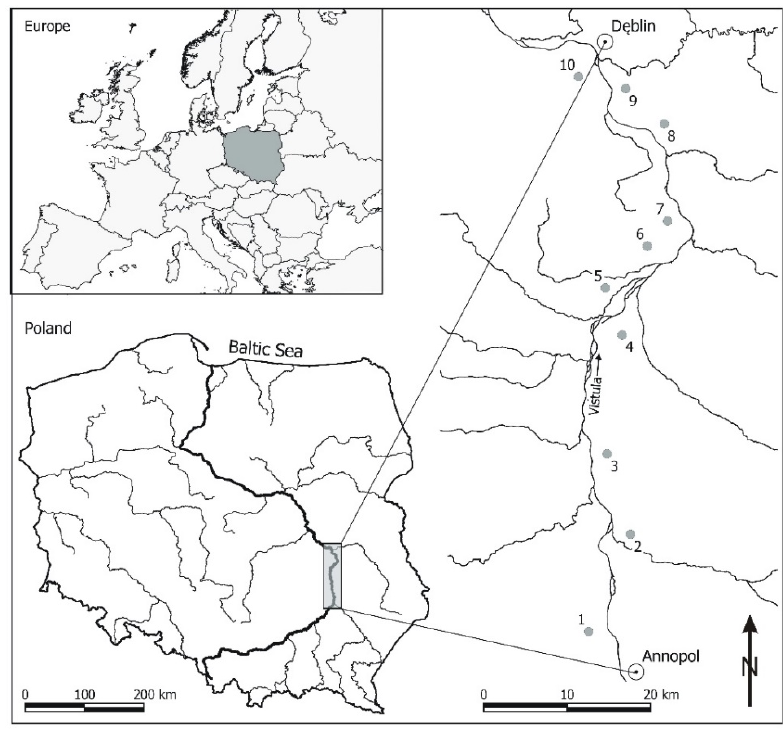
Figure 2. The study area, the Vistula River, Poland (1–10—studied reservoirs).